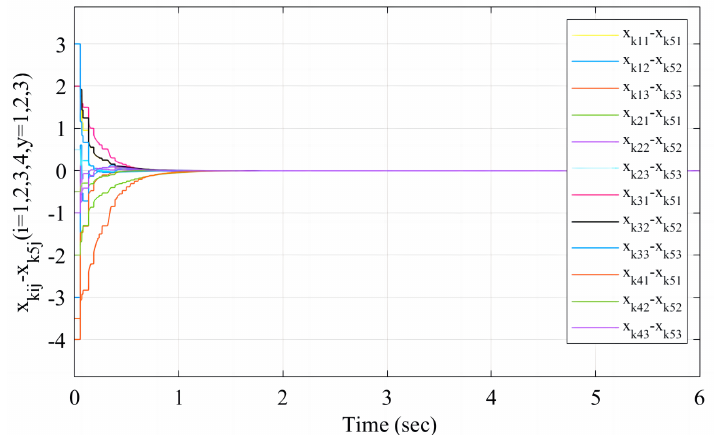
Figure 4. Tracking error trajectories of nodes with event-triggered protocol without DoS attacks.